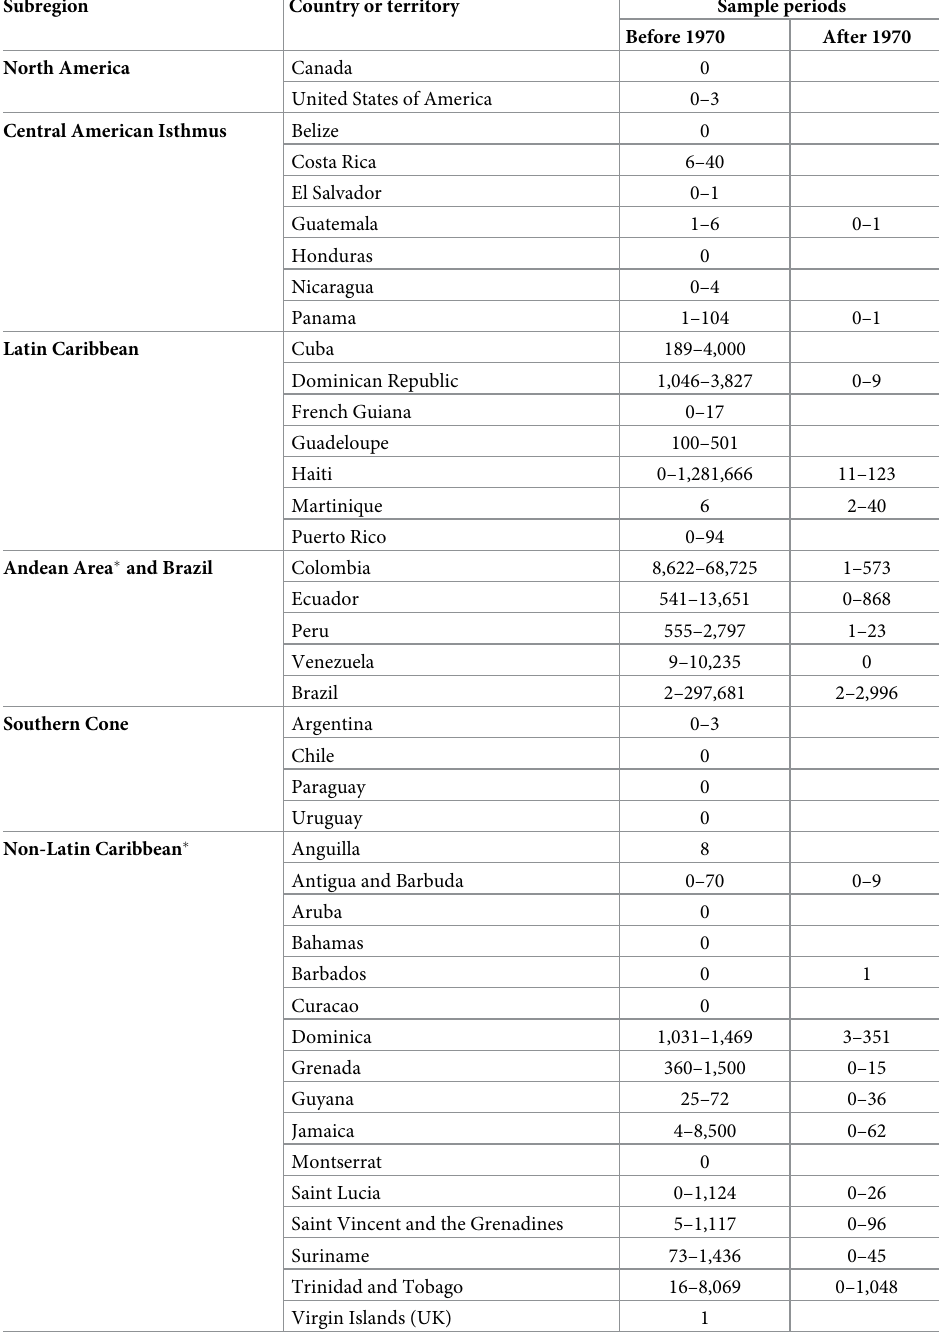
Table 2. Number of cases of yaws per year (range) in general population by country or territory and sample